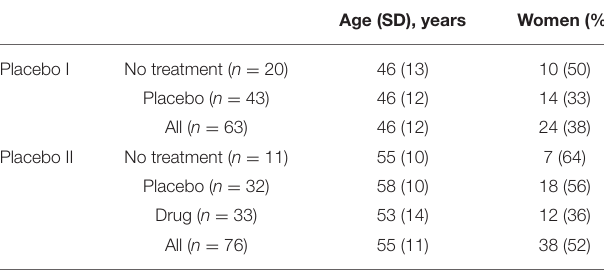
TABLE 1 | Demographic characteristics of Placebo I and Placebo